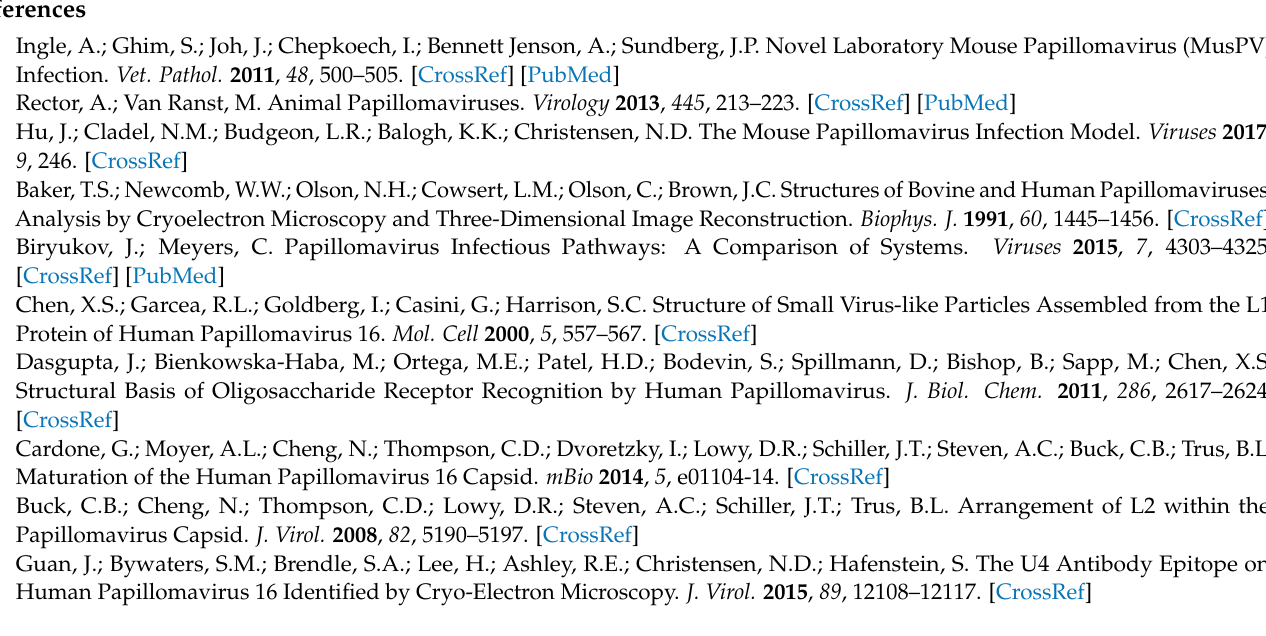
Figure S1: Micrograph with rod like structure, Figure S2: Statistical Tests of Unequal Variances, Figure S3: Lesions virus sample was purified from, Figure S4: TEM Negative Stain image of virus before vitrification, Figure S5: Sequence alignment of HPV16 and MmuPV1 L1 major capsid